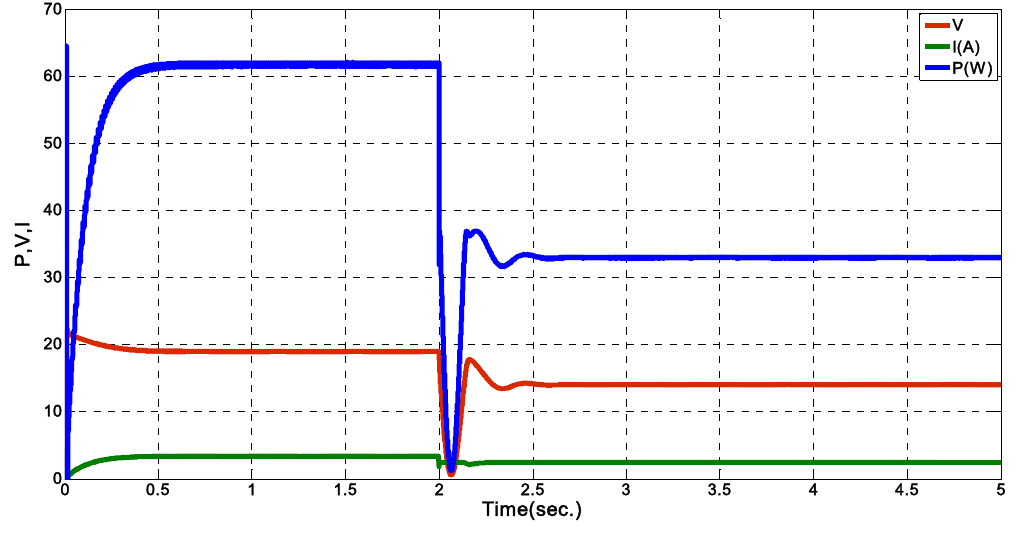
Figure 15. Time response of a SinESC system in the context of an abrupt irradiance change from 1 kW/m 2 to 600 W/m 2 at time = 2